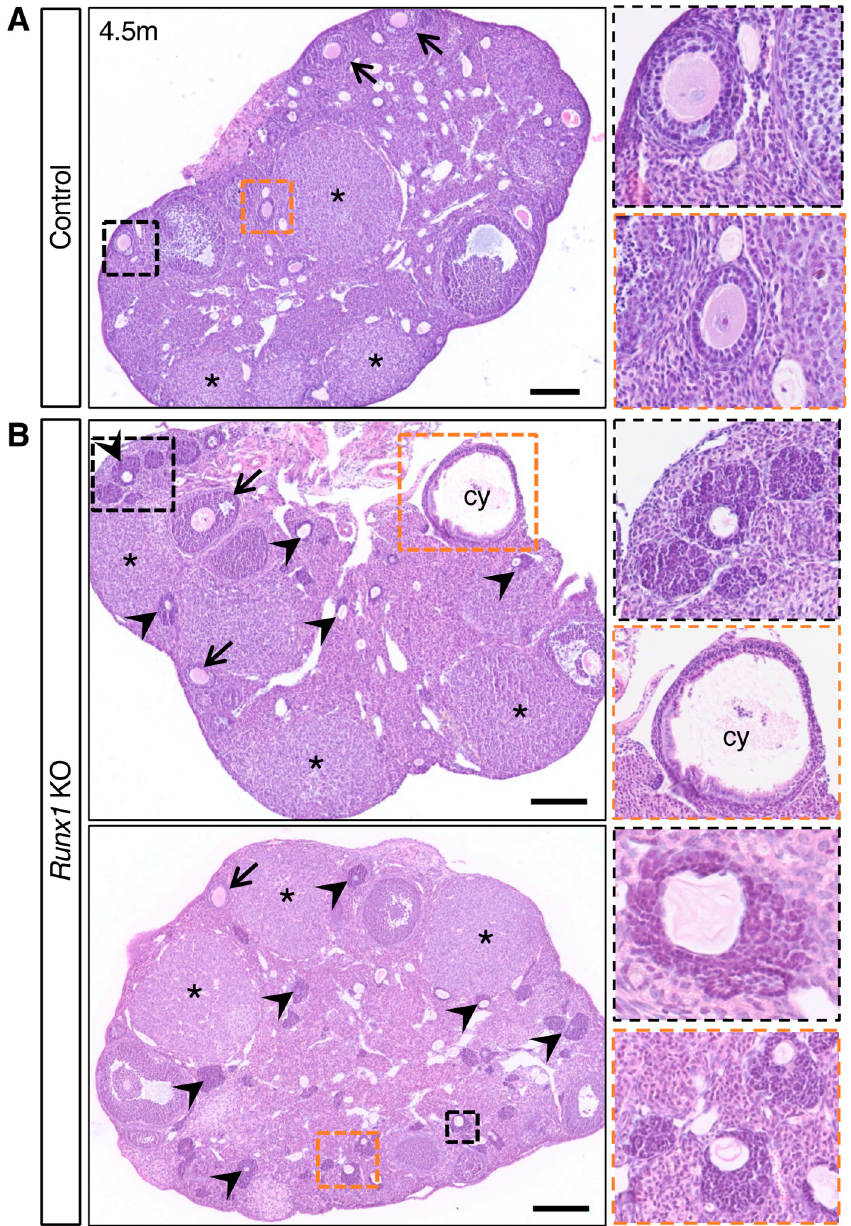
Figure 3. Ovarian defects in young adult Runx1 knockout mice: H&E-stained sections of representa- tive 4.5-month control ( A ) and Runx1 KO ovaries ( B ) ( n = 6/genotype). Black and orange panels on the right are higher magnifications of outlined areas. Arrows indicate normal follicles; arrowheads indicate follicle-like lesions; asterisks indicate corpora lutea; cy represents cyst. Scale bars: 200 µ